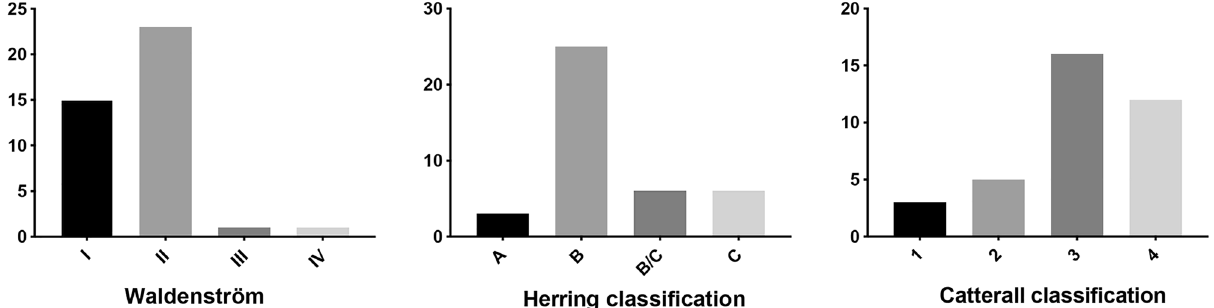
Figure 3. Waldenström, Herring classification and Catterall classification in case